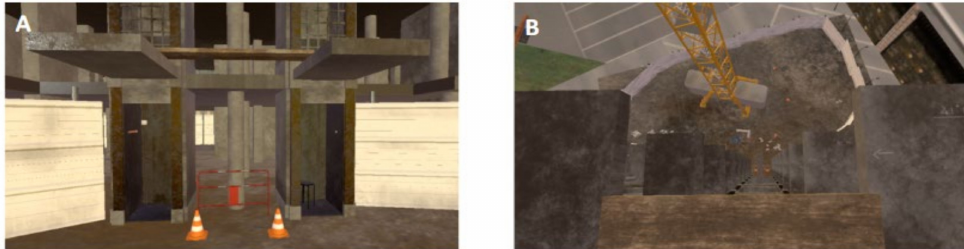
Figure 5. Screenshot of two elevators allow to climb the building ( A ). Cross between two platforms on a plank allows to reach the next elevator in a building with 99 floors ( B